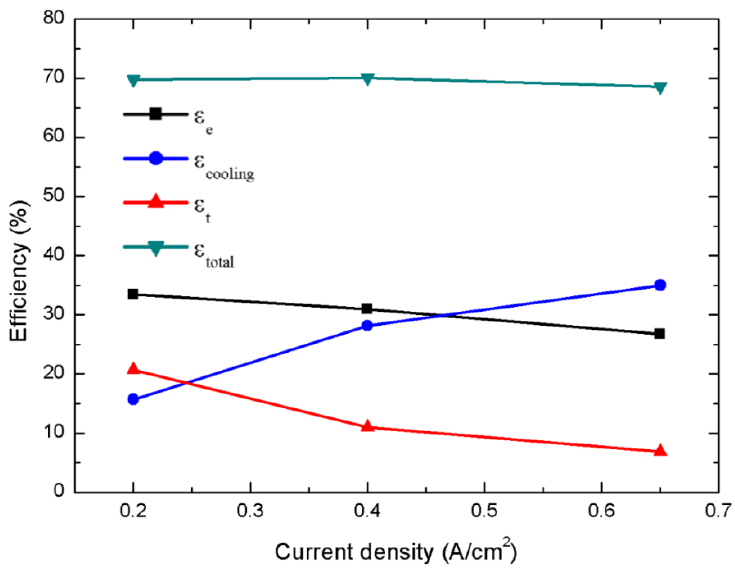
Figure 9. Curves for the electrical, cooling, thermal, and overall efficiencies under various current